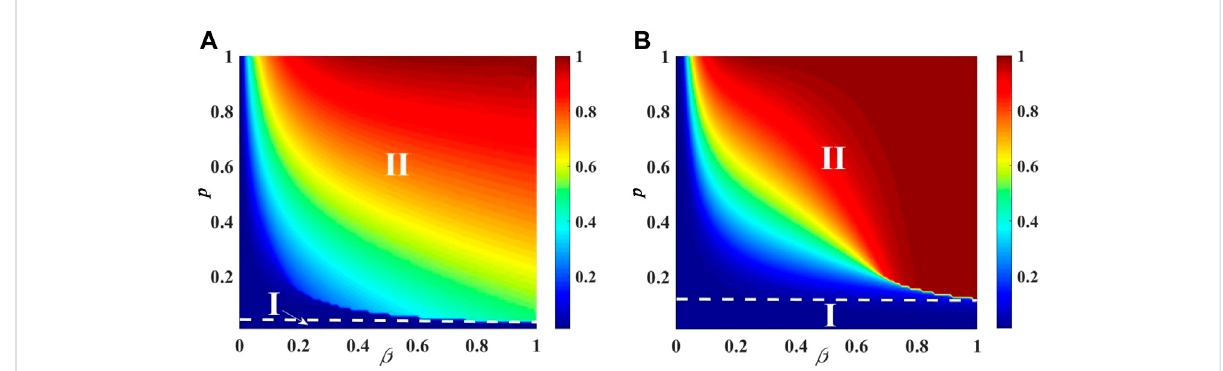
FIGURE 5 The combined impact of active student score and unit propagation probability on the fi nal adoption size of weighted SF network users. The effects of ( β , p ) on the ultimate adoption size at v = 2.4 are shown in subparagraphs (A) and (B) , respectively. In (A,B) , two regions appeared: region